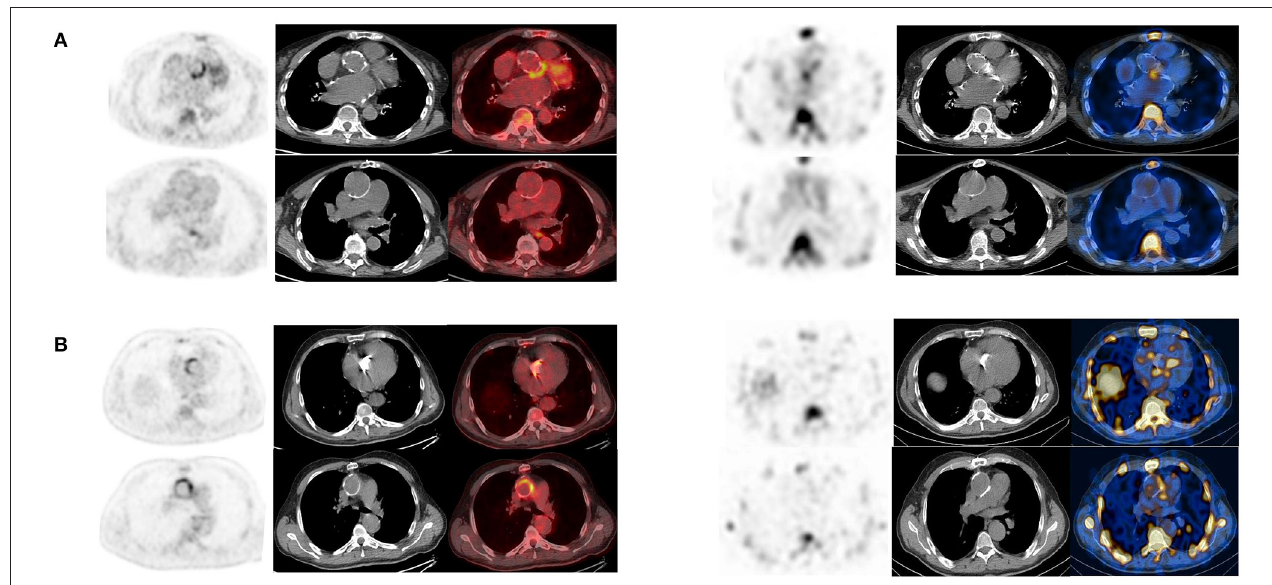
FIGURE 5 | (A,B) Examples of concordant findings between [ 18 F]FDG PET/CT (left panel, from left to right transaxial emission, CT and superimposed images) and WBC scan (right panel, from left to right transaxial emission, CT and superimposed images) in two patients with very early infection showing uptake of the corresponding radiopharmaceutical at both the imaging modalities localized at the TG (A) and at both the AV and the TG (B) .